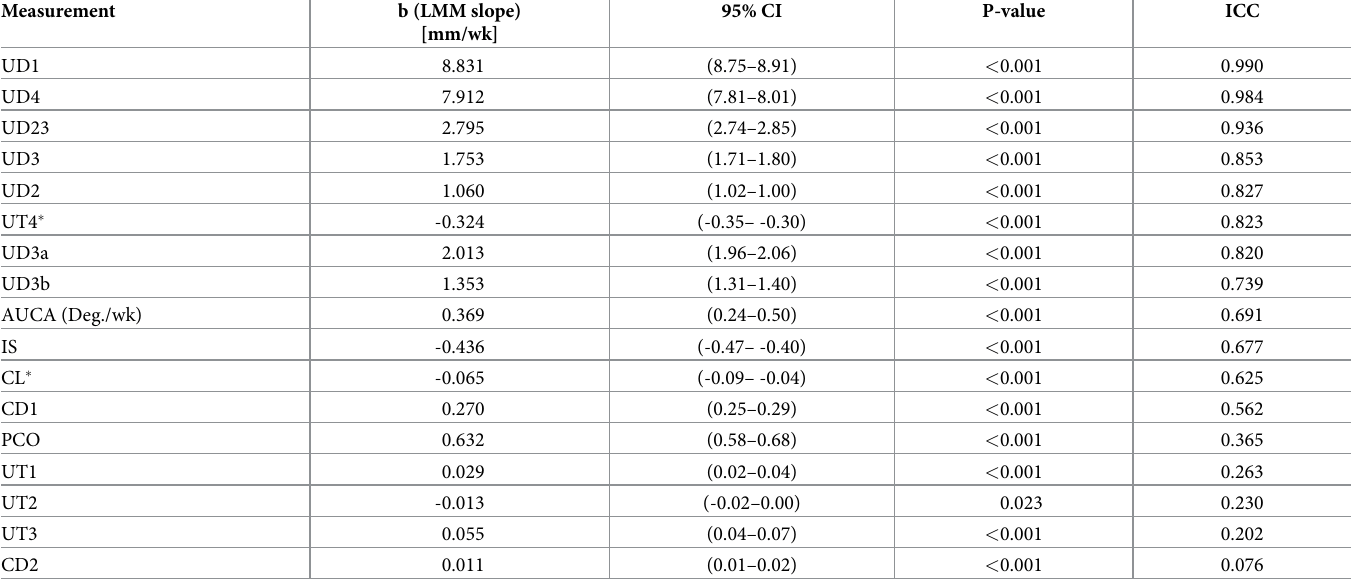
Table 2. Summary of linear mixed model and ICC results for each parameter sorted by highest to lowest ICC value. LMM slope estimates (mm/week) in linear mixed effects models adjusting for parity and position (supine versus standing). The line indicates the cutoff between good and fair measurements, as prescribed in the methods section. � Indicates measurements for which parity was significant and included in the